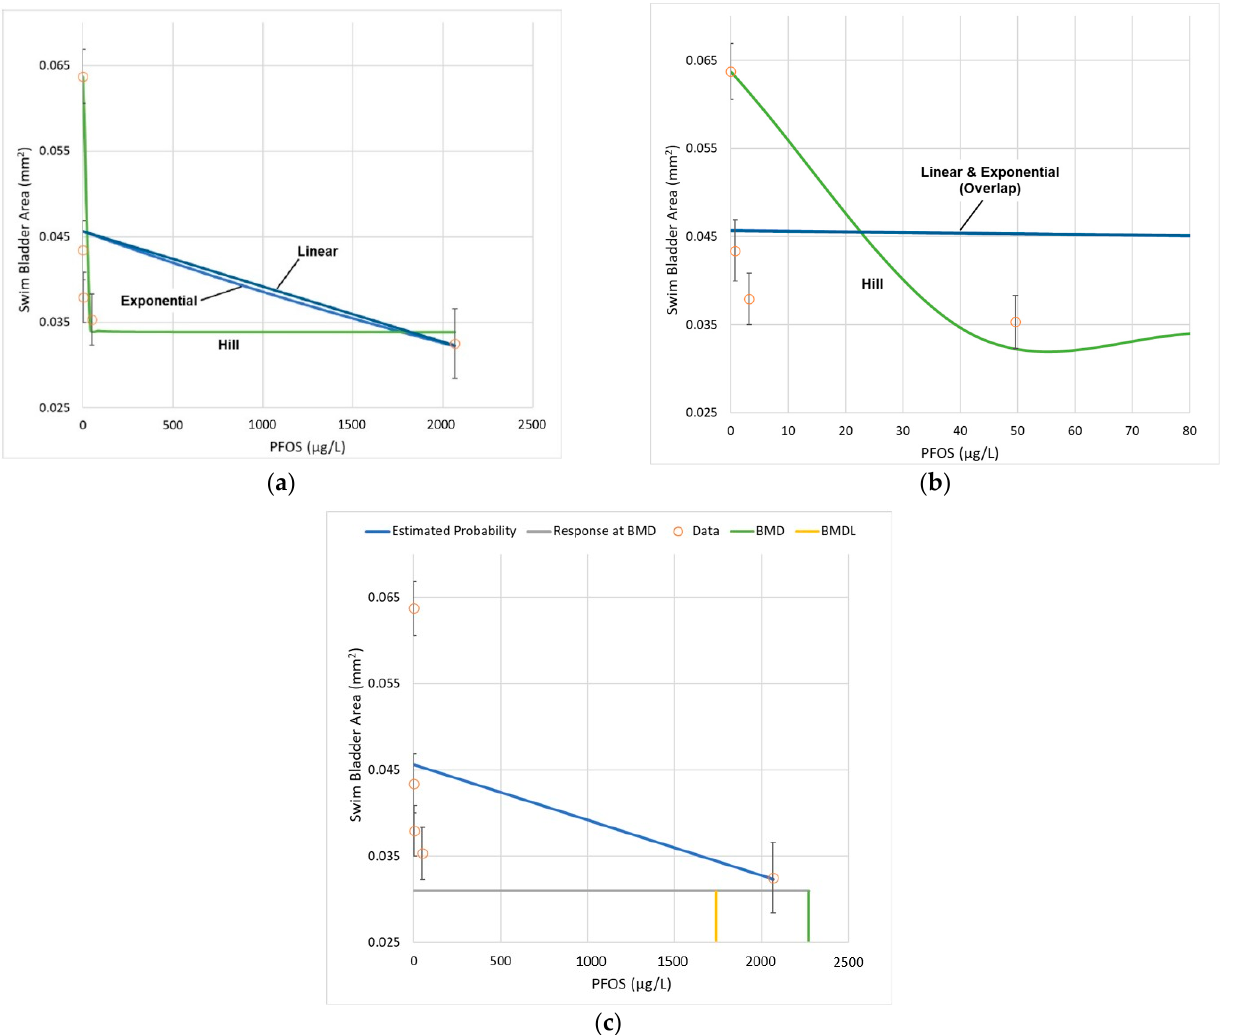
Table 4. BMD and BMDL estimates for PFOS for the SBA endpoint. Dose–Response Model